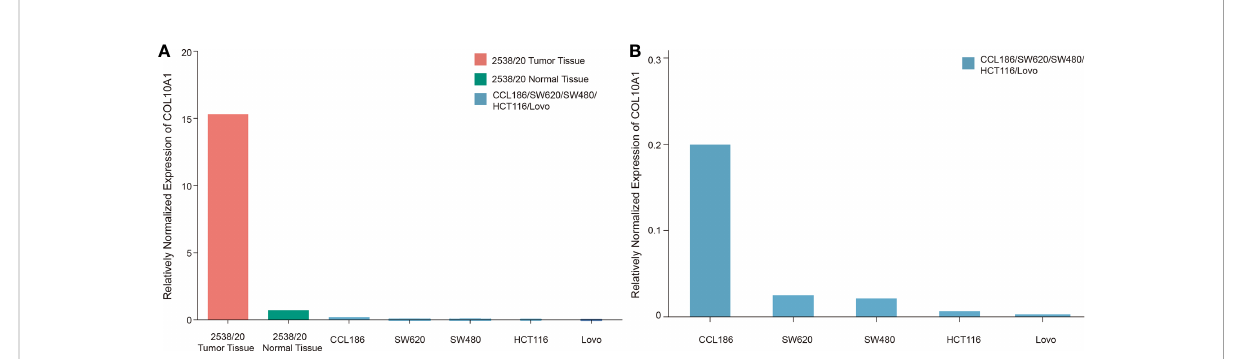
FIGURE 6 Relatively normalized expression (RNE) of COL10A1 in solid tumor, adjacent normal colon tissue, and CRC and fi broblast cell lines. For RNE, the sample with the lowest CT value is set as reference (value: 1) for other tissues and cell lines. CT values were normalized on GAPDH. (A) Illustration of multiple increased expression levels in CRC tumor stroma compared with in vitro cultured CRC cell lines and fi broblasts. (B) Enlarged breakdown of COL10A1 expression levels of common fi broblast and CRC cell lines. Fibroblasts (CCL186) were shown to have an eightfold increased expression compared to the strongest expressing tumor cell SW620.